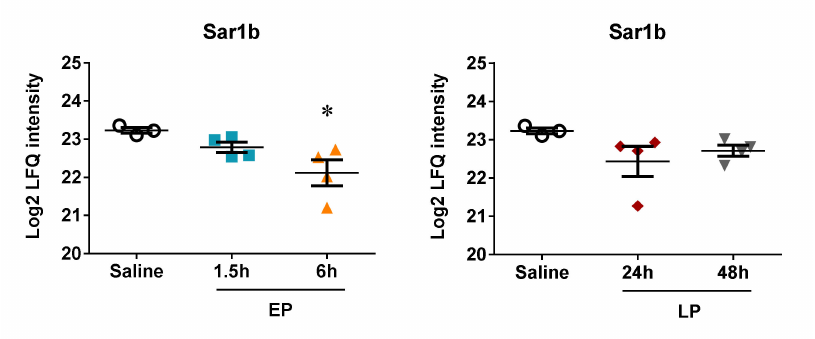
Figure 7. Protein expression of the miR-762 predicted target GTP-binding protein Sar1b in the kidneys of mice after LPS administration. Log2 transformed label-free quantification (LFQ) intensity values of proteins were determined by mass spectrometry. Left column: EP, right column: LP. Secretion associated Ras related GTPase 1B (Sar1b). Data are expressed as mean ± SEM; one-way ANOVA; *: p < 0.05.